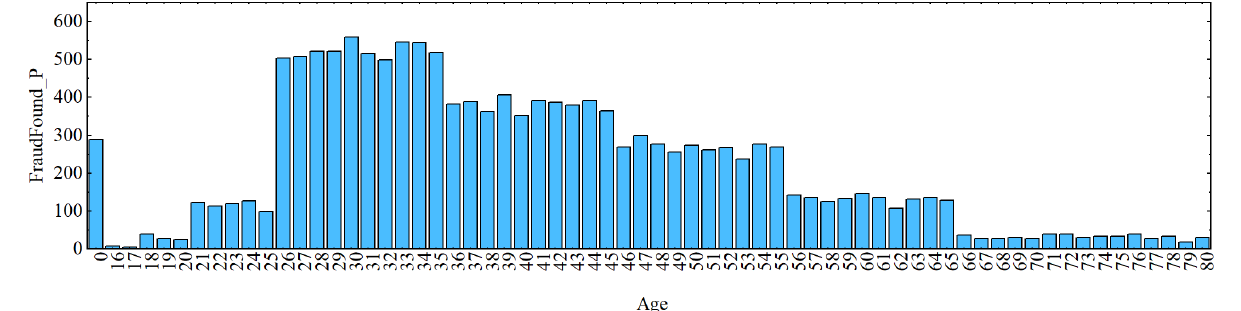
Figure 3. Association between Age and No Fraud Found. The y axis “FraudFound_P” represents the number of rows for FraudFound_P = 0.